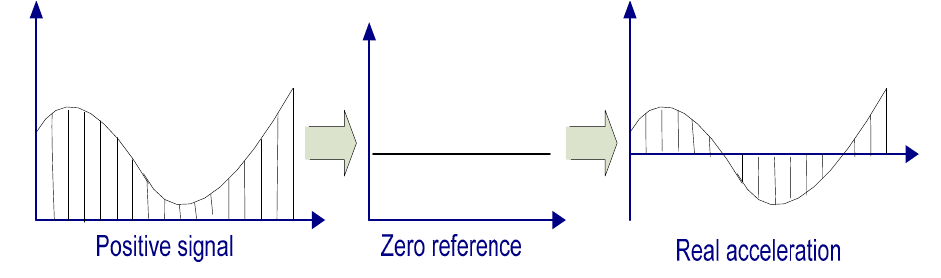
Figure 4. Normalization stage.